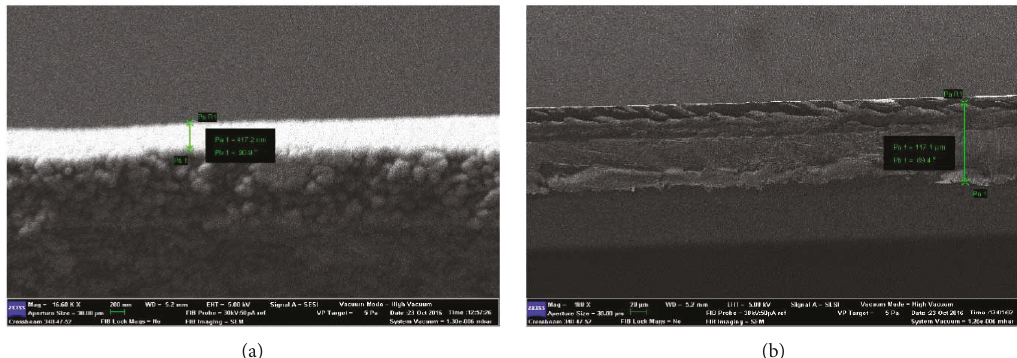
Figure 3: Cross-sectional SEM images of the printed layer. (a) Scale bar =200nm. (b) Scale bar =20 μ